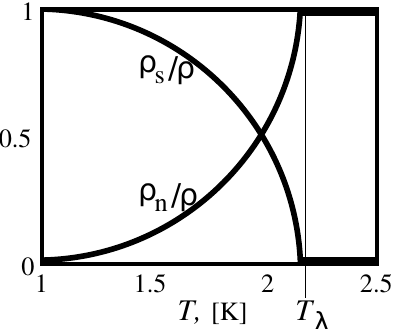
Figure 5. Temperature dependence of the relative superfluid and normal components, ρ s / ρ and ρ n / ρ , as functions of T . T λ is the critical λ -point